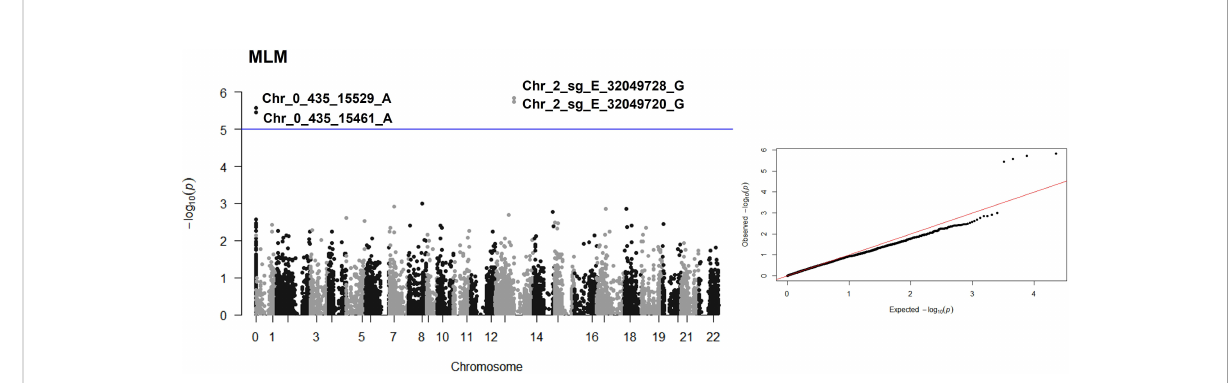
FIGURE 2 Manhattan plot and Q-Q plot corresponding to single-locus GWAS MLM for C. arabica and P. syringae pv. garcae interaction. The manhattan plot indicate the -log10(p-value) of SNP across the genome (y-axis) plotted against their respective position on each chromosome (x-axis). The blue line represents the Bonferroni corrected threshold. The chromosome (Chr) zero correspond to scaffolds that did not have a de fi ned position during the genome assembly, Chr 1 to 11 correspond to canephora subgenome, Chr 12 to 22 correspond to eugenioides